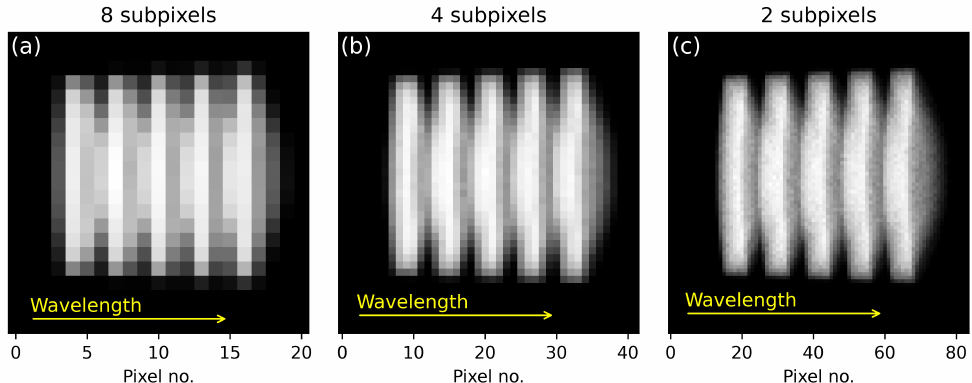
Figure 2. Zemax simulations of linear dispersion in the DMD plane; in each of the illustrations we show five images, corresponding to five different wavelengths of the entrance slit. In the figures, spectrally separated images of the entrance slit with a width of 350 µ m are shown. Five wavelength elements with 10.5 nm spectral distance (2180 nm, 2190.5 nm, 2201 nm, 2211.5 nm, 2222 nm) are simulated. For each wavelength element an image of the slit is projected onto the DMD surface; resolution of the slit images for different DMD sub-pixel groupings: ( a ) 128 pixels; 8 sub-pixels per DMD super-pixel, ( b ) 256 pixels; 4 subpixels per DMD super-pixel ( c ) 512 pixels; 2 sub-pixels per DMD